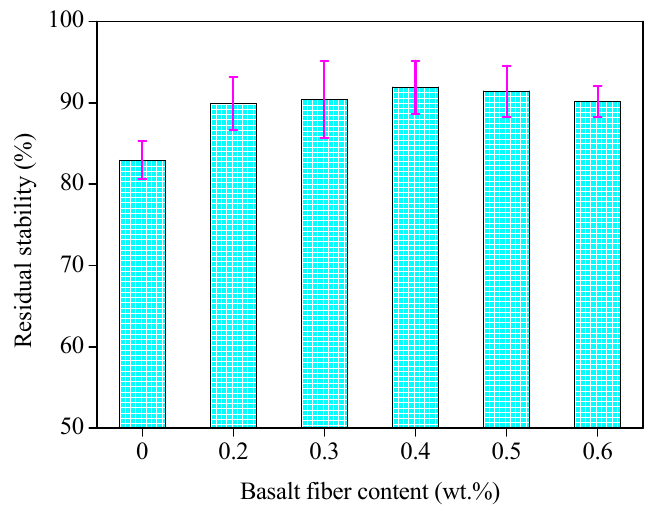
Figure 18. Residual stability of basalt reinforced asphalt mixture with different fiber contents.